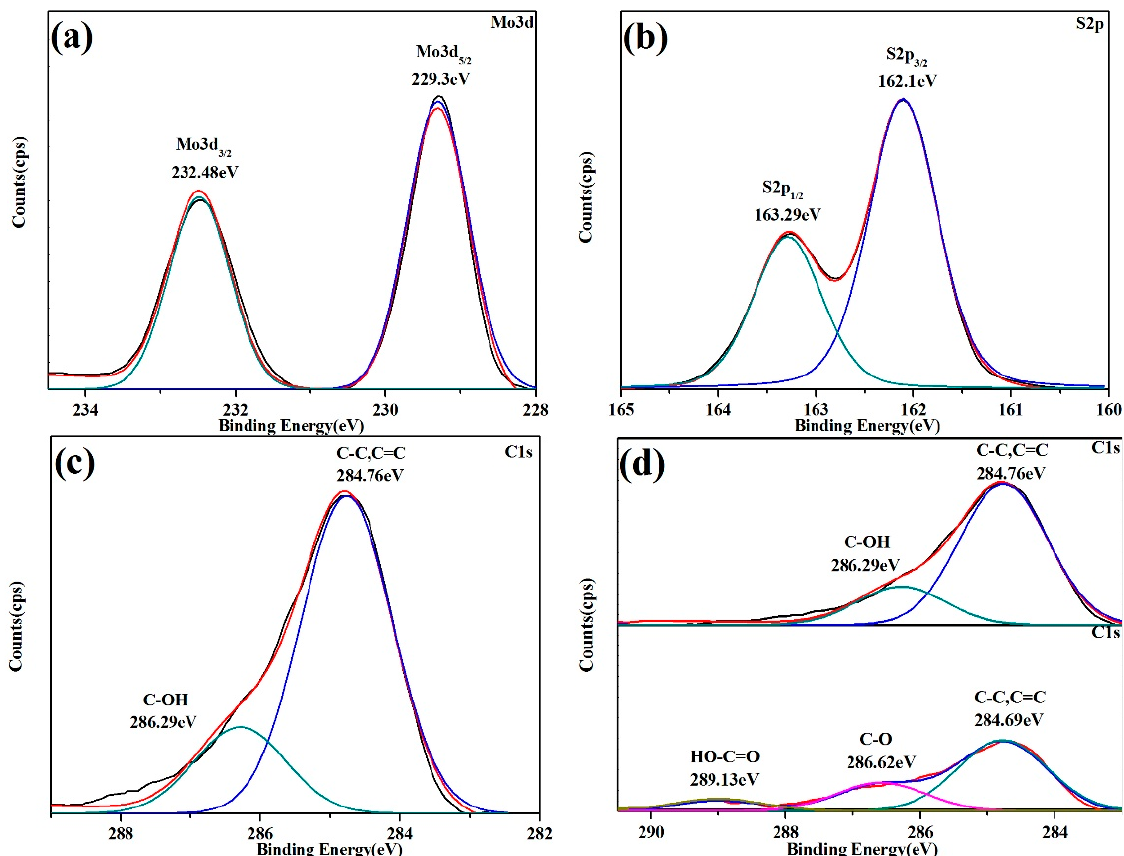
Figure 7. XPS spectra of ( a ) Mo 3d core-level structure, ( b ) S 2p core-level structure, ( c ) C 1s core-level structure, and ( d ) comparison of C1s in the products synthesized by the IHC method ( top ) and the simple DIC method ( bottom ).